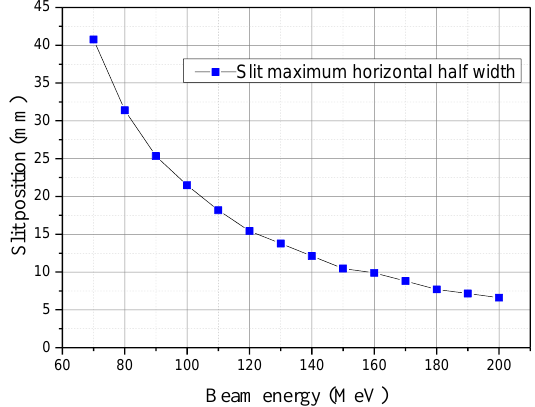
Figure 11. The analytical calculation of the correspondence between the slit maximum positions and the energies selected.